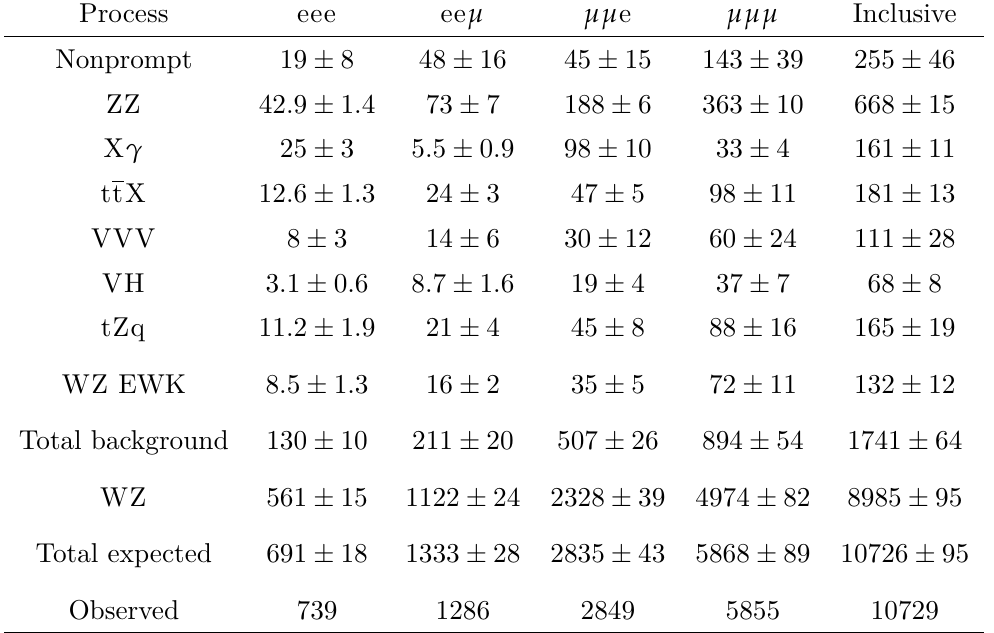
Table 3 . Expected and observed yields after the combined fit for the relevant SM processes in the SR of the analysis in each of the different lepton flavour combinations for all the data taking years. Total uncertainties affecting each process are included at their postfit values next to the predicted